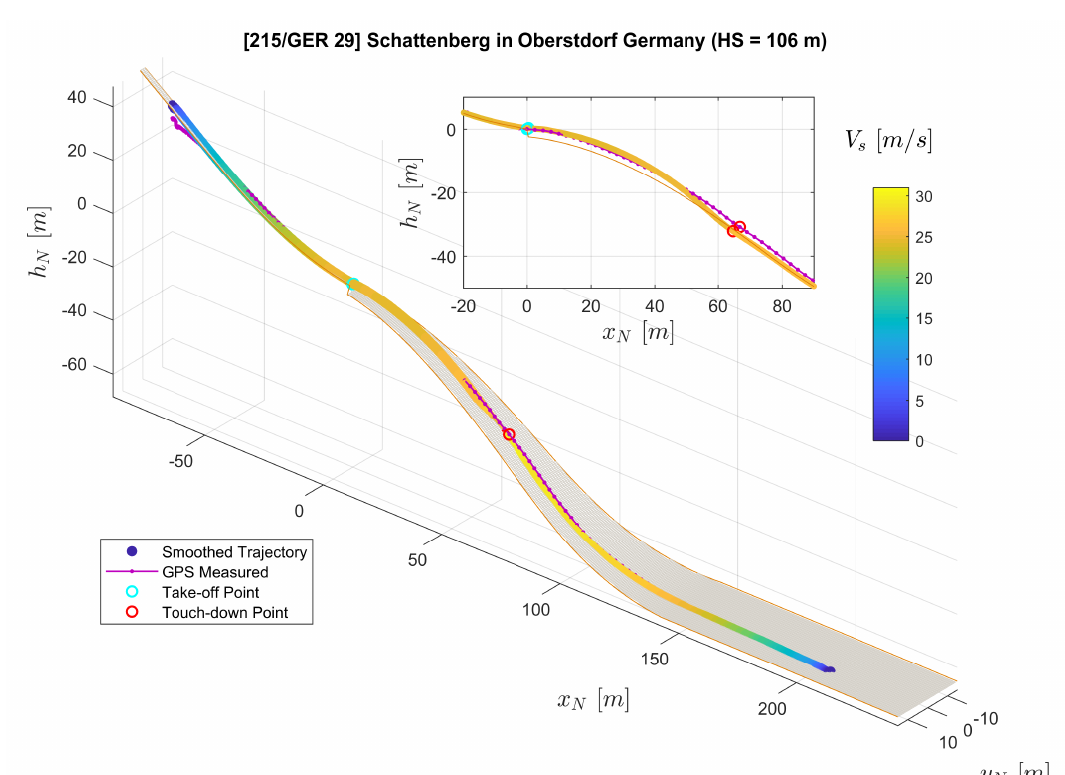
Figure 17. Trajectory Reconstruction result for Jump No.